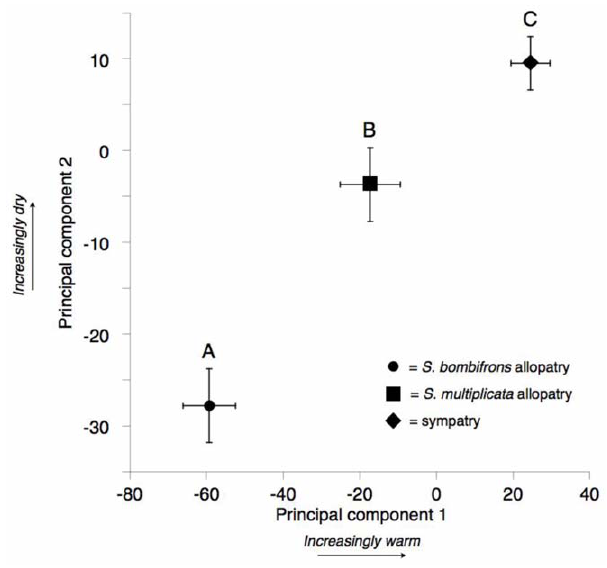
Figure 5. Principal components of the abiotic environment. Means ( + / 2 s.e.) for the first two principal components describing variation in the eight environmental variables used to build ecological niche models. Different letters indicate significantly different means; each group ( S. multiplicata in allopatry, S. bombifrons in allopatry, and sympatry), is significantly different from the other two.